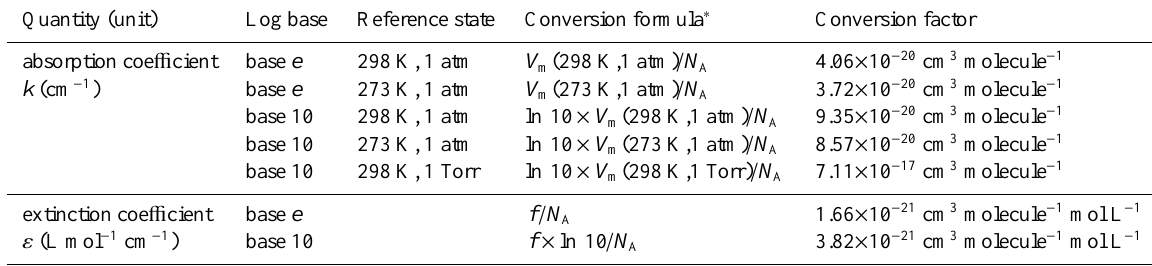
Table 4. Conversion factors from absorption coe ffi cients k and extinction coe ffi cients ε to absorption cross sections σ in cm 2 molecule − 1